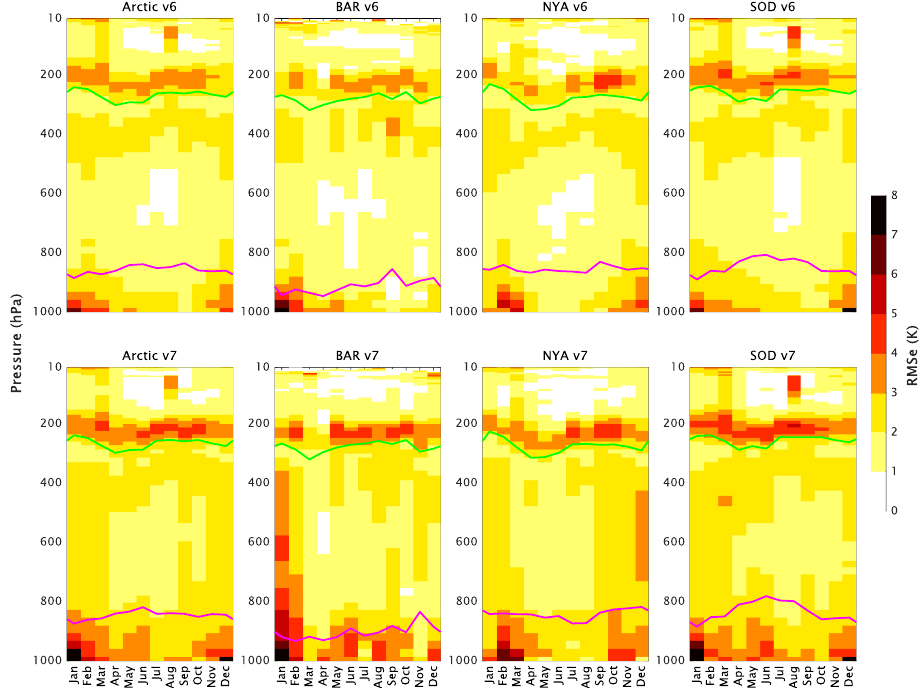
Figure 5. Same as in Figure 4, but for RMS errors between the RS92 and AIRS v6 ( upper ) and v7 ( lower ) temperature profiles.